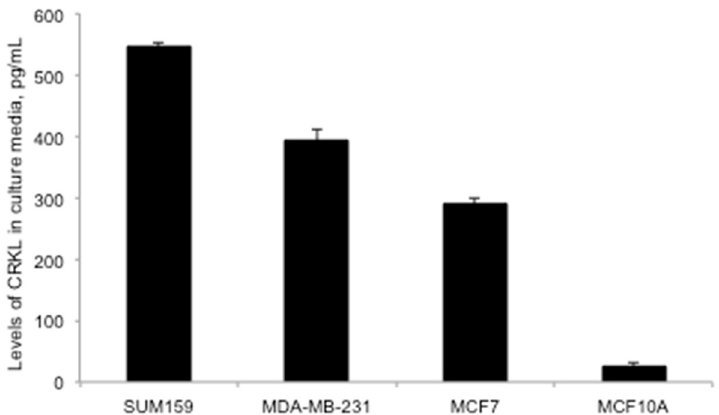
Figure 2. Assessment of secreted Crk-like protein (CrkL) levels in vitro in cancer media collected from breast cancer cells (MCF7, MDA-MB-231, and SUM159) versus normal breast epithelium cells (MCF10A), the data analyzed by Enzyme Linked Immuno-Sorbent Assay (ELISA), n = 5–6; p < 0.001 comparing levels in all the evaluated breast cancer cells with levels of soluble CrkL in the cell media from MCF10A cells.